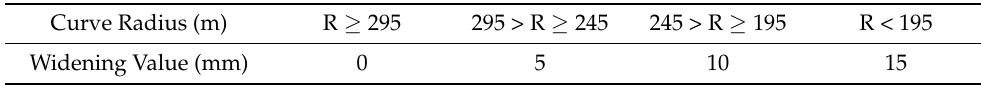
Table 15. Current gage widening values